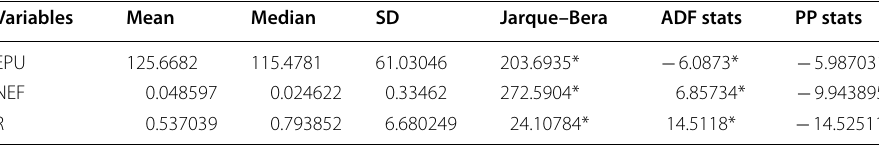
Table 1 Descriptive statistics and unit root tests